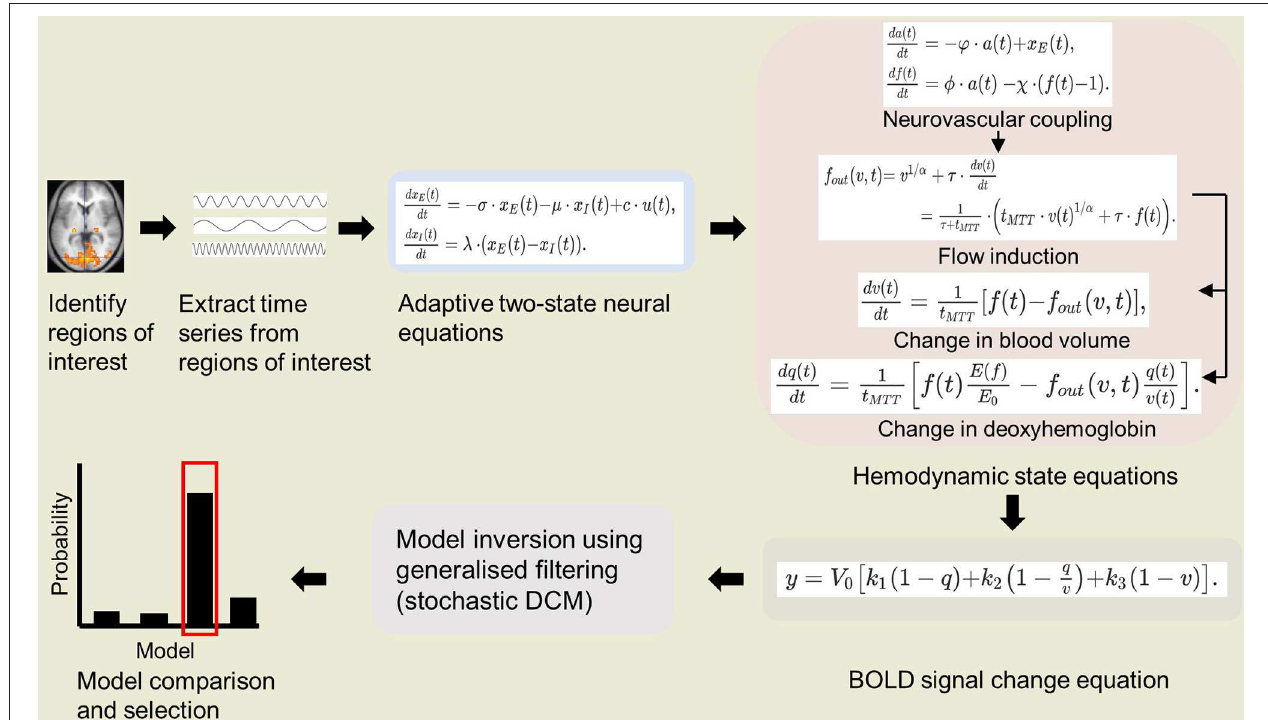
FIGURE 1 | Schematic of integrated physiologic-stochastic DCM (IPS-DCM). After identifying and extracting the time series from regions of interest, model parameters are then estimated using P-DCM equations ( Havlicek et al., 2015). P-DCM incorporates: (1) an adaptive two-state neuronal model that allows adaptation and refractory effects to neuronal response; (2) a hemodynamic model that implements feedforward neurovascular coupling and a viscoelastic effect on the Balloon model; (3) a BOLD signal change equation that accounts for magnetic field differences. The model inversion is done using generalized filtering (stochastic DCM) (Li et al., 2011). Lastly, one proceeds to model comparison and selection of the winning